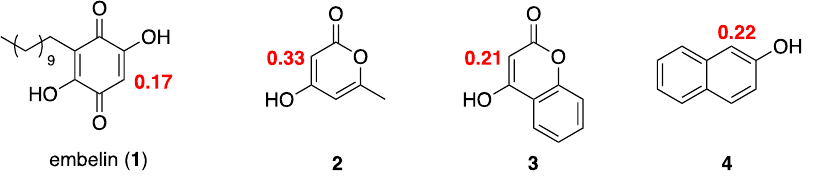
− ) for compounds ( 1–4 k